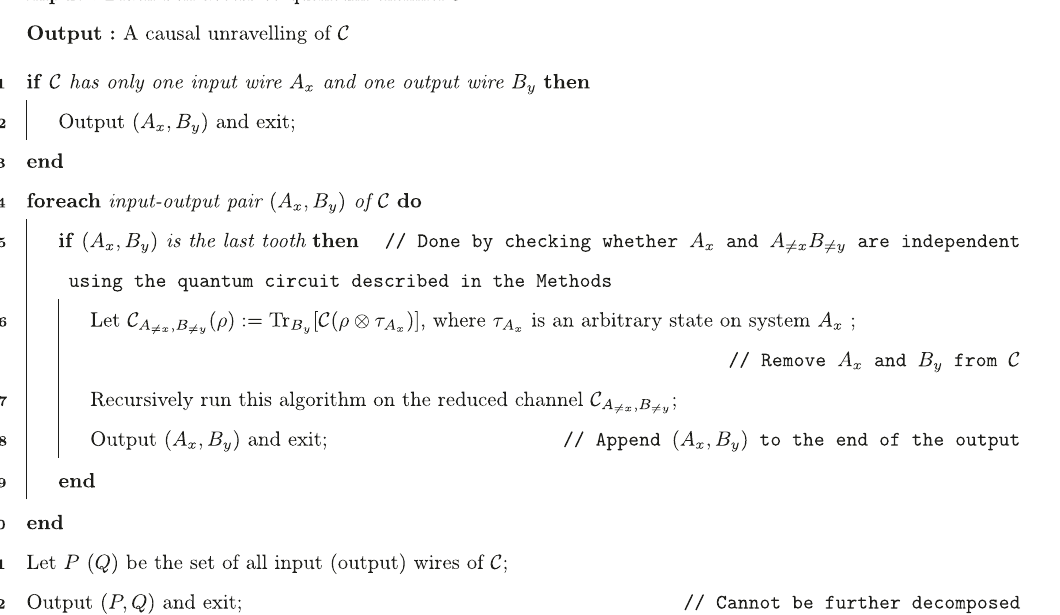
Algorithm 1 . Ef fi cient quantum causal unravelling